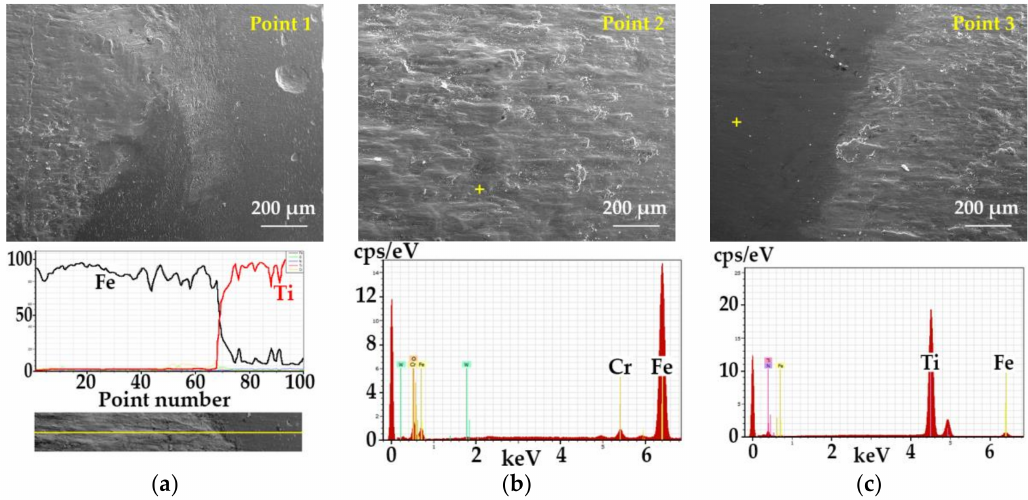
Figure 10. An EDX microanalysis of the punch surface coated by TiCN-MP after 120,000 strokes in selected areas: ( a ) point 1; ( b ) point 2; ( c ) point